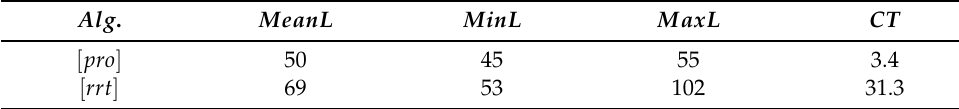
Table 2. MATLAB simulation results (scenario 2).